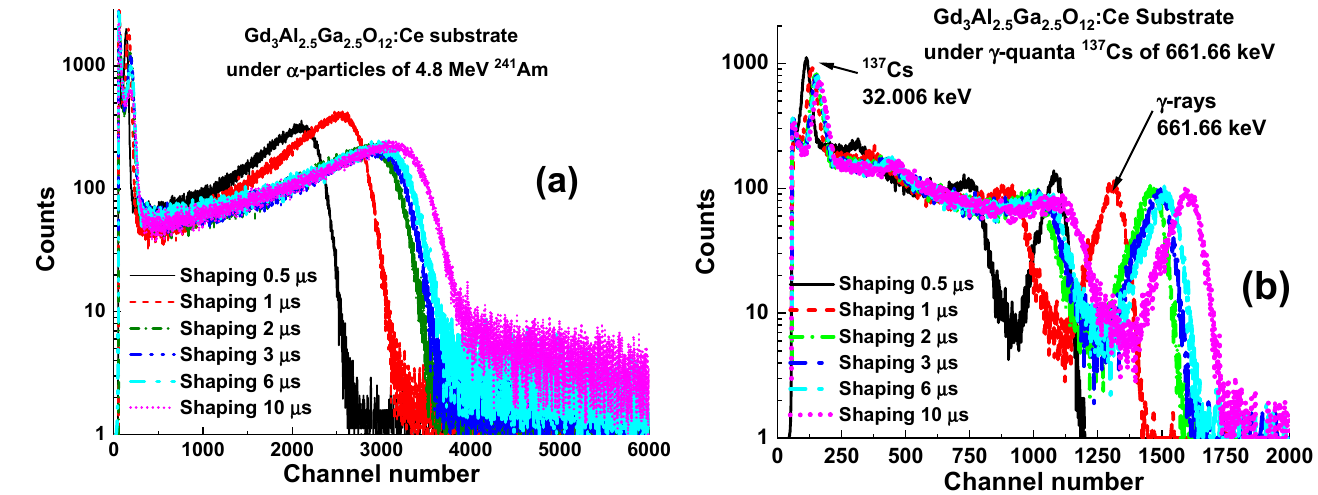
(b) 544 Figure 6. ( a ) Normalized XRL spectra of the selected Lu-Gd- ( a ) and Tb-Gd-based ( b ) composite scintillators in comparison with GAGG:Ce substrate and reference BGO scintillator. The pulse-height spectra of GAGG:Ce substrate under α -particle and γ -quantum excitations measured at different shaping times are presented in Figure 7, while the dependences of light yield (LY) on shaping time for some studied composite scintillators are displayed in Figure 8. LYs under α -particle and γ -ray excitation are summarized in Table 3. The measured ratio of the LY under γ -ray and α -particle excitation was about 7.6, and this value is quite consistent with the data of [7].